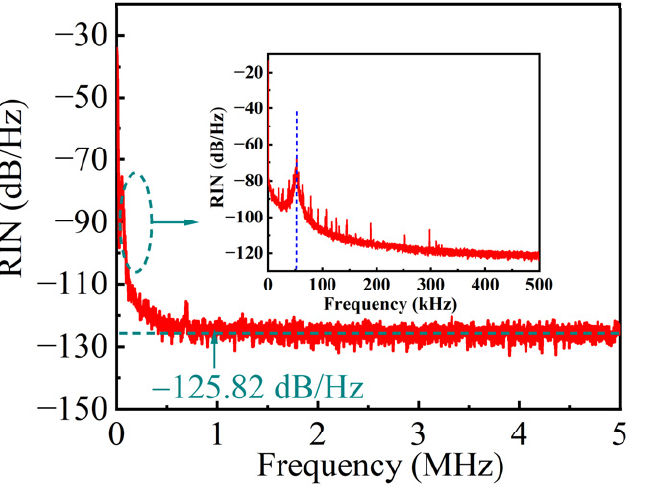
Figure 7. RIN spectrum of the laser with a frequency range of 0–5 MHz with a 10 kHz RBW, and inset shows the same measurement in 0–500 kHz using RBW of 100 Hz.